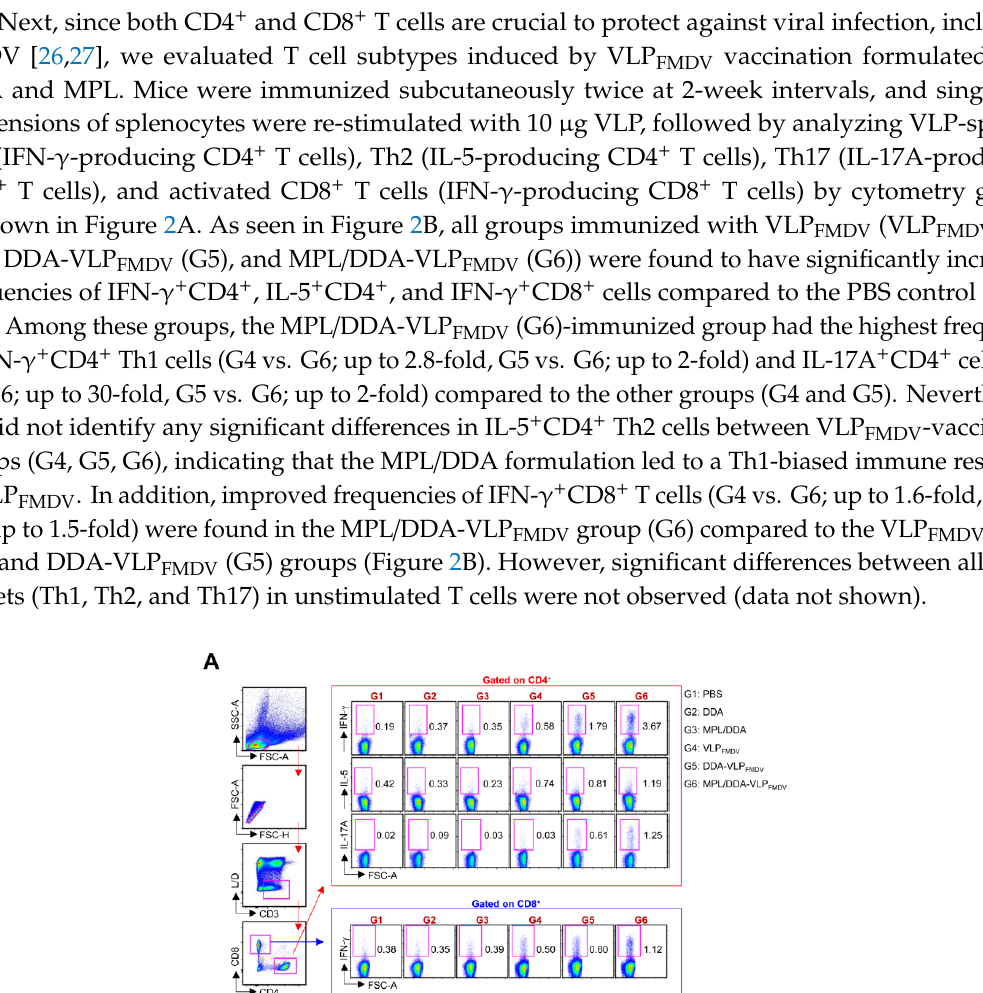
analyzed by flow cytometry. ( C ) Single-cell suspensions of splenocytes were treated with 10 µ g / mL VLP for 24 h, and supernatants were collected and evaluated for VLP-specific cytokines (IFN- γ , IL-5 and IL-17A) by ELISA. The means ± SD shown are representative of two independent experiments. * p < 0.05, *** p < 0.001. n.s.: not